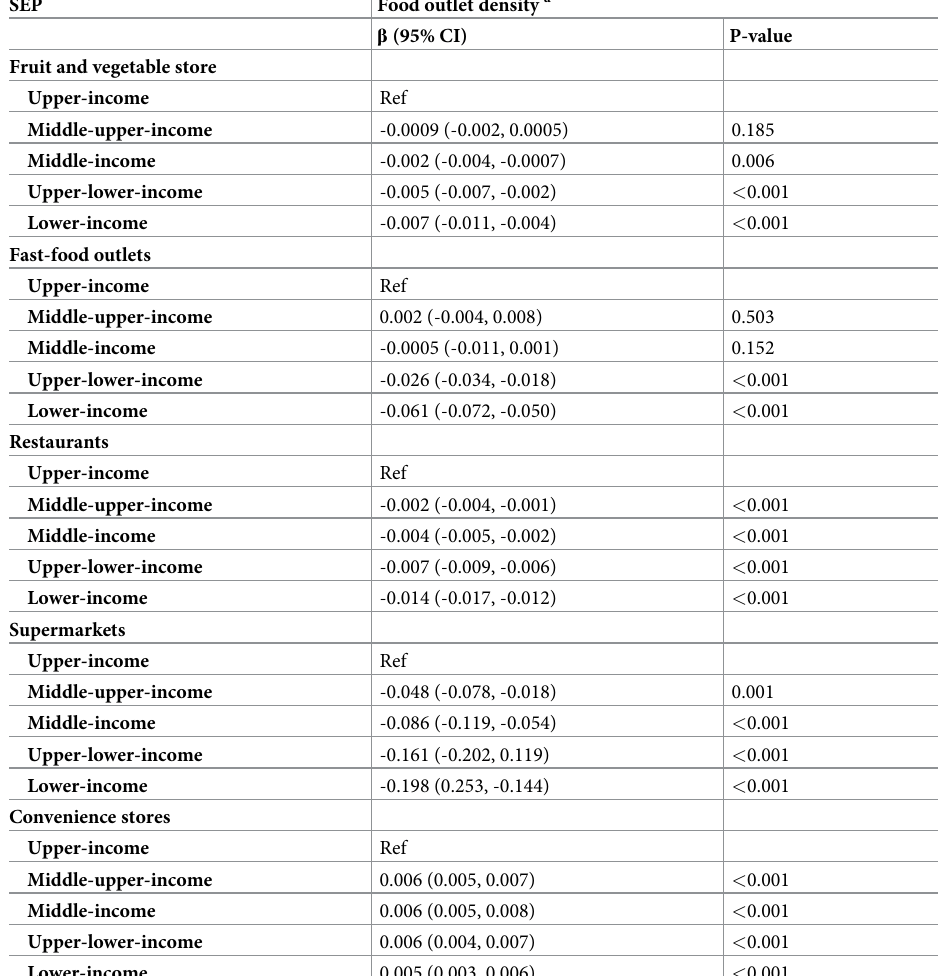
availability of fruit and vegetable stores, compared with higher-income households ( β : -0.007, 95% CI -0.0011, -0.004), P < 0.001) (Table 4). Furthermore, when stratifying the association of dietary patterns with fruit and vegetable store density by household SEP, upper-income house- holds were more likely to consume healthy dietary patterns ( β : 0.004, 95% CI: 0.0004, 0.007, P = 0.027). Additionally, middle-upper-income households were less likely to consume unhealthy dietary patterns when exposed to high densities of fruit and vegetable stores ( β : -0.003, 95% CI: -0.006, -0.0002, P = 0.036) (Table 5). A low fast-food outlet density was associated with lower-income ( β : -0.061, 95% CI: -0.072, -0.050, P < 0.001) and upper-lower-income households ( β : -0.026, 95% CI: -0.034, -0.018,